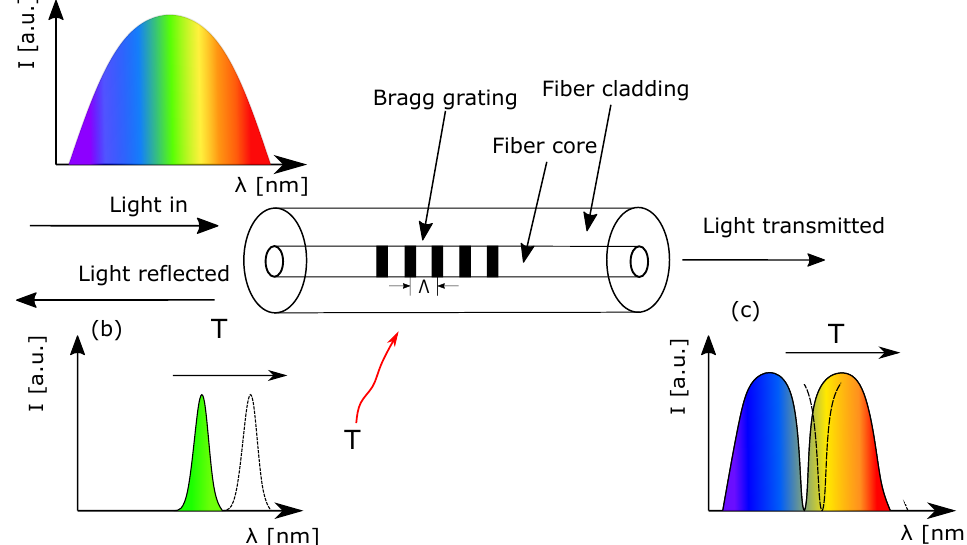
Figure 2. Operating principle of the fiber Bragg grating. The FBG works as a wavelength-domain filter that reflects the narrowband of an incident spectrum. When external stressors act on FBG, its reflection spectrum changes. In subfigure ( a ), an incident spectrum is shown. In ( b , c ), a reflected and transmitted spectrum are presented,